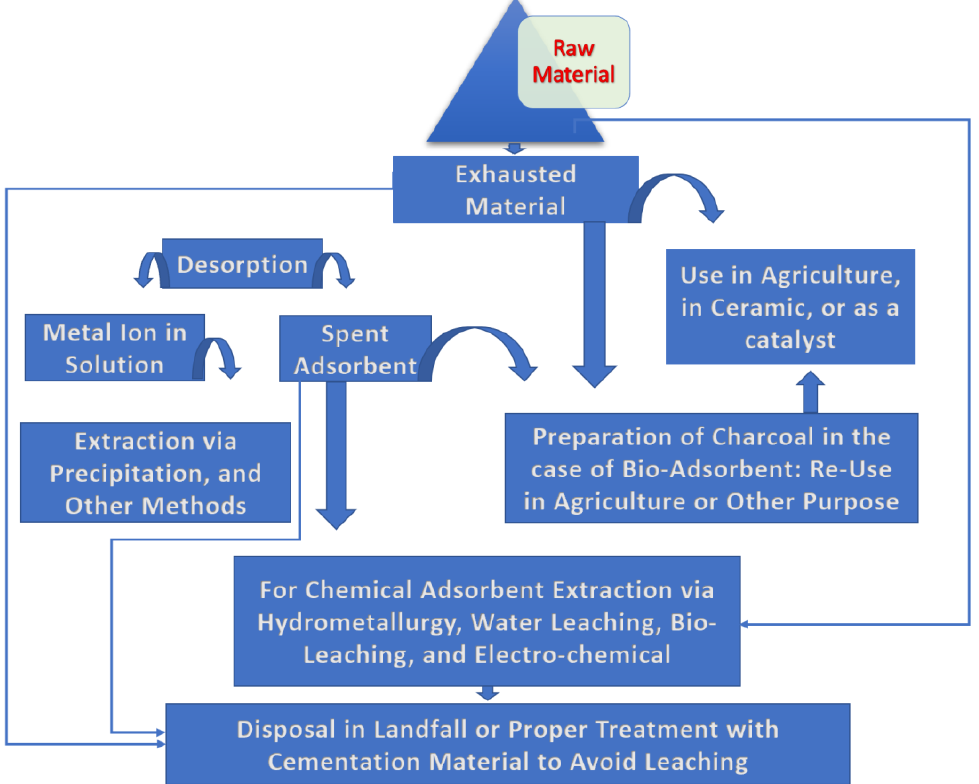
Figure 7. Adsorbent disposal management after